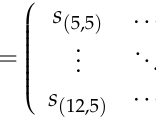
Table 1. The MAEs, MREs, and R 2 of different models.